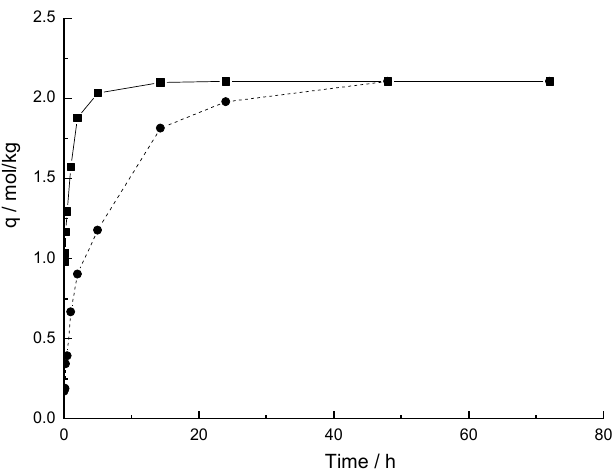
Figure 29. Time variation of the amount of gold(III) on CPW (●)gel and DMA-PW (■)gel from 0.1 mol·dm −3 hydrochloric acid solution [36] (with permission for reuse from Elsevier